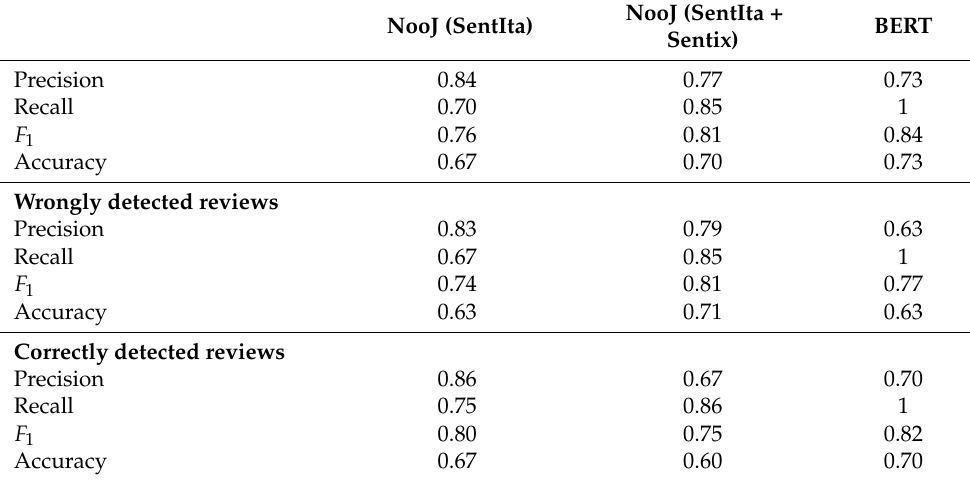
Table 6. Segment-level